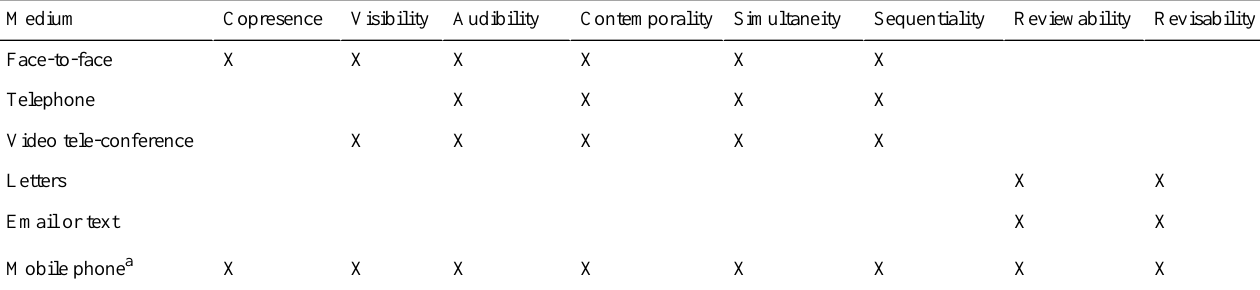
Table 2. Constraints on communication comparison chart. X refers to a supported constraint.